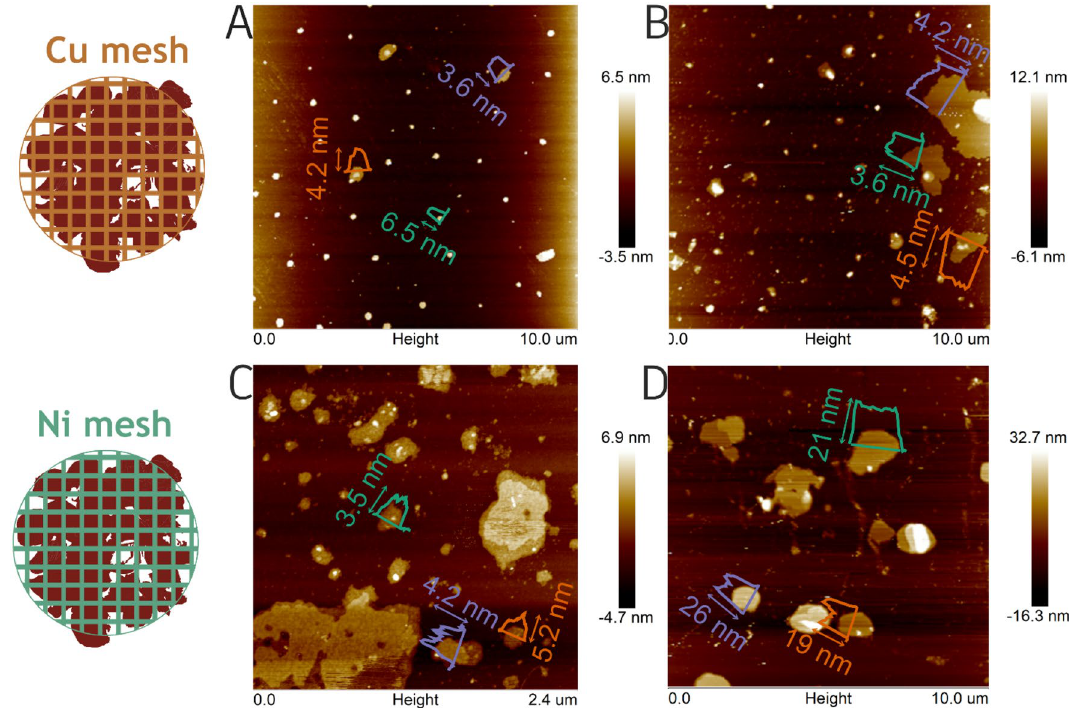
Figure 2. AFM images of borophene sheets after electrochemical exfoliation on A Cu_Li + _1 A, B Cu_